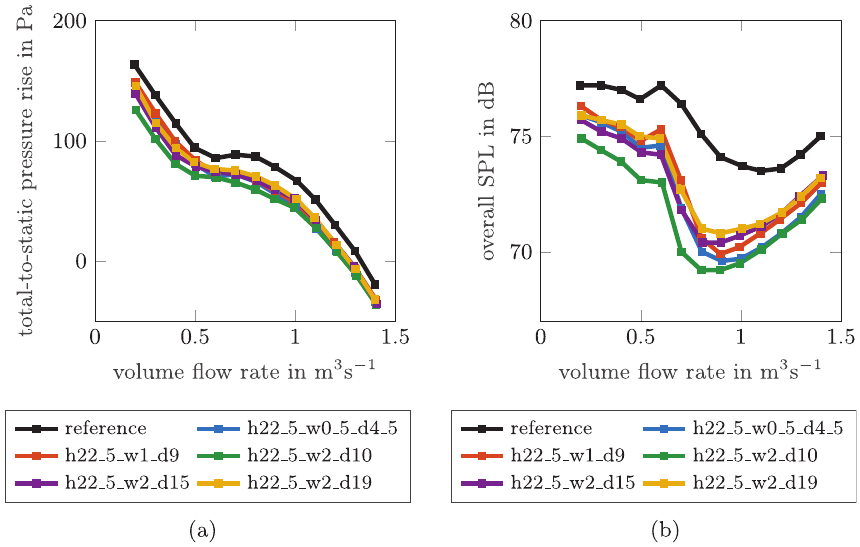
Figure 4. Characteristic curves for the reference fan and the fans with slitted leading edges. (a) Aerodynamic curves, (b) overall sound pressure levels.